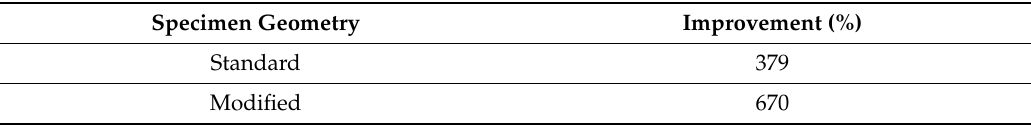
Table 5. Improvement percentages provided by the carbon fiber